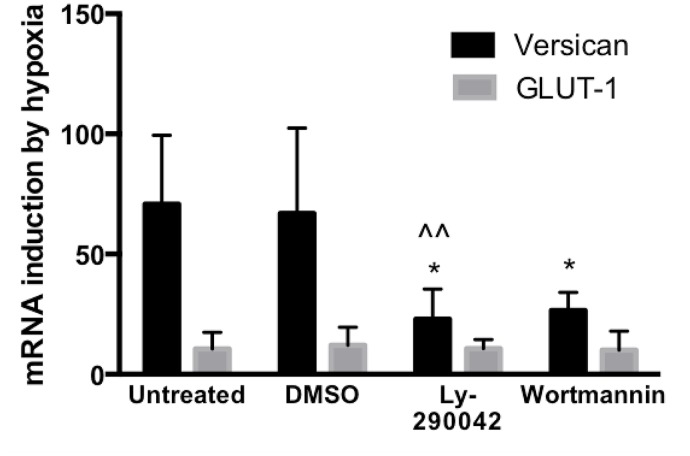
Real Time RT-PCR analysis of the effect of PI3K inhibitors on induction of versican and GLUT-1 mRNAs by 18h of exposure to hypoxia (0.2% O2).LY290042 was used at 2μM and wortmannin at 300μM. ^^; p<0.05 compared to DMSO control, *; p<0.05 compared to untreated control, ratio paired t test, one tailed. Data from 5 independent experiments using HMDM from different donors, expressed as means ± SEM.